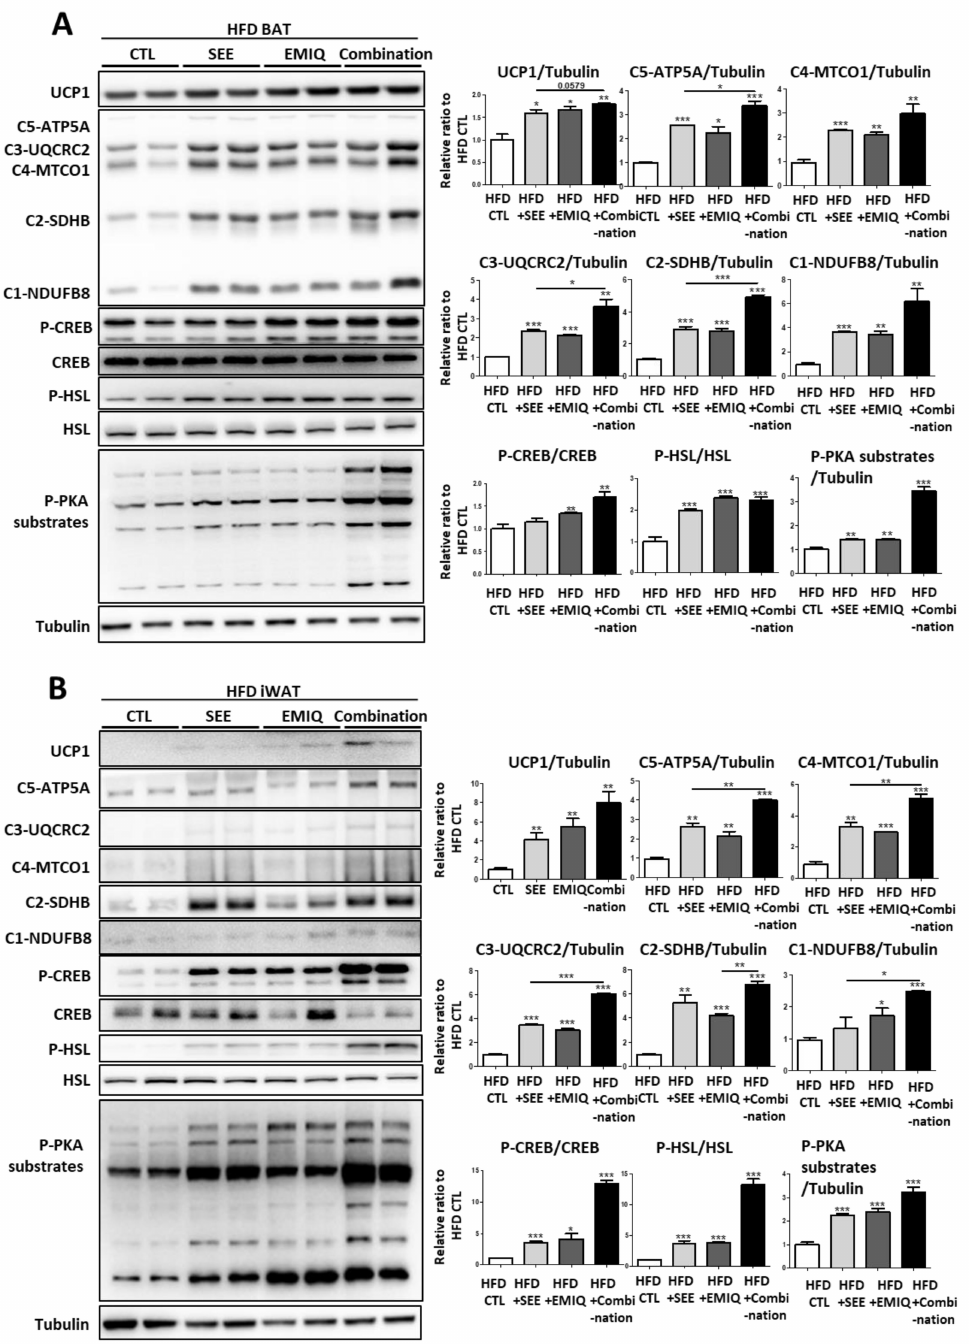
Figure 5. E ff ects of in vivo SEE, EMIQ, and combination (SEE + EMIQ) treatment on mitochondrial content and browning marker expression in adipose tissues of high fat diet-induced obesity model. ( A , B ) Immunoblot analysis of UCP1, and proteins involved in mitochondrial oxidative phosphorylation, and PKA signaling ( A ) in BAT and ( B ) iWAT of mice treated with vehicle (CTL), SEE (400 mg / kg), EMIQ (100 mg / kg), and combination (SEE 400 mg / kg + EMIQ 100 mg / kg) for two weeks ( n = 6, means ± SEM, * p < 0.05, ** p < 0.01, *** p <